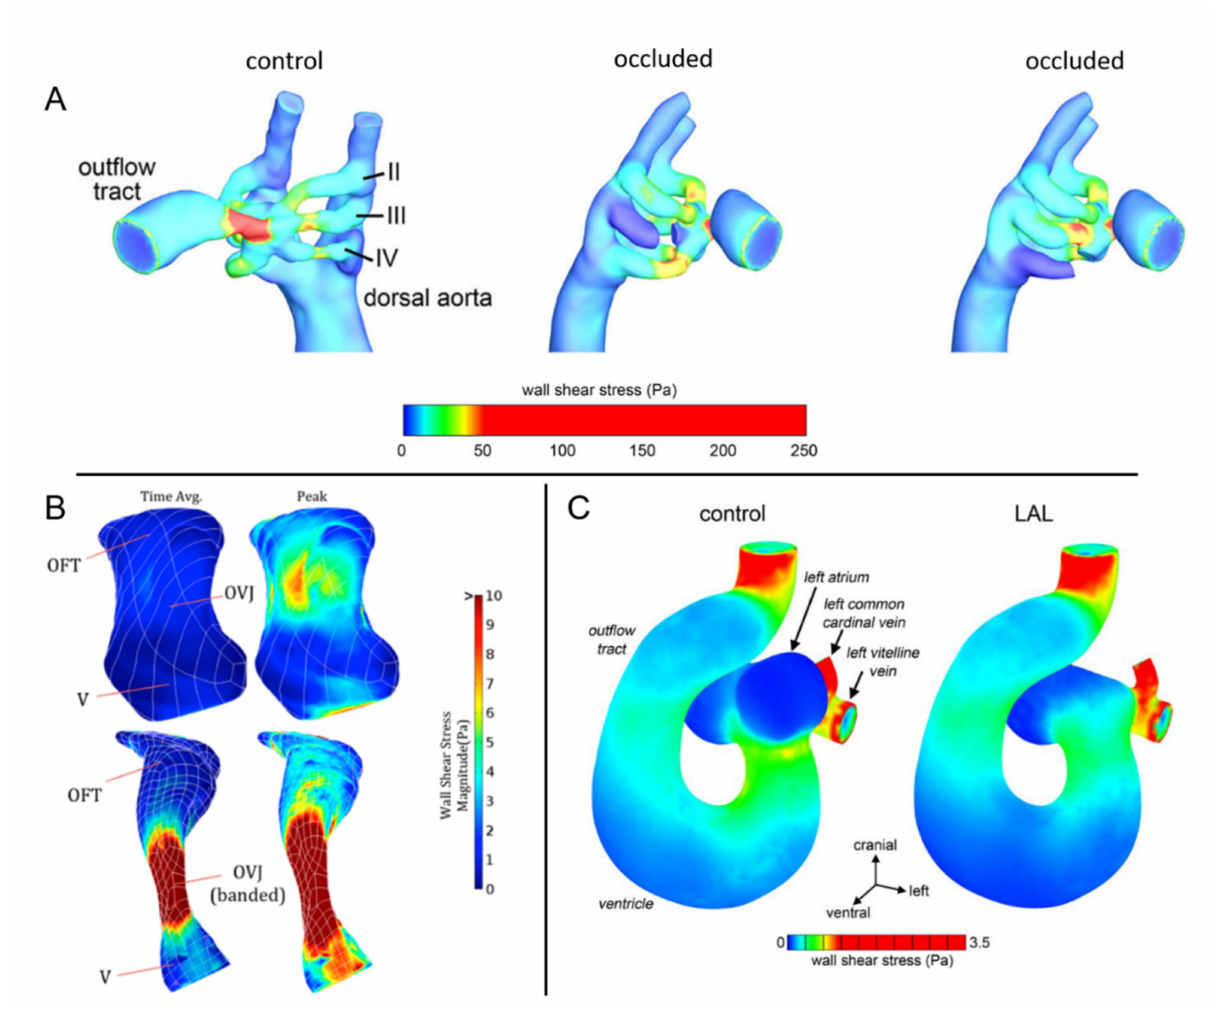
Figure 3. WSS comparison of normal and defected chicken embryos. Significant alterations in WSS are observed between normal and defected embryos. ( A ) Peak WSS on control and occluded chicken embryos at Hamburger–Hamilton stage 18 (HH18). Right lateral aortic arches are shown by II, III, and IV (Reproduced from Lindsey et al. (2015) [107]). ( B ) Peak and time-averaged WSS on control (at top) and OFT banded (at bottom) chicken hearts at HH16-17. V: ventricle, OVJ: OFT/ventricle junction (Reproduced from Menon et al. (2015) [111]). ( C ) WSS distribution on control and left atrial ligated (LAL) embryos at HH21 (Kowalski et al. (2014)